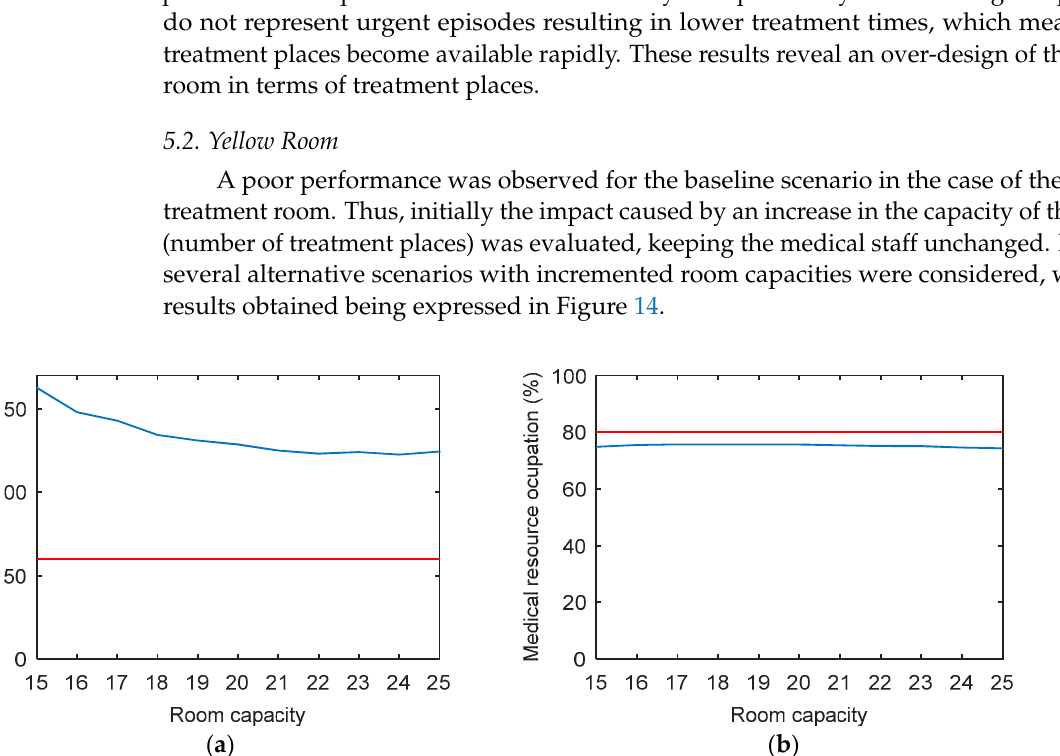
Figure 13. Obtained values for different capacity scenario: ( a ) waiting time for first medical intervention (blue line — simulation model, red line — Manchester time); ( b ) medical resource occupation (blue line — simulation model, red line — occupation rate limit).